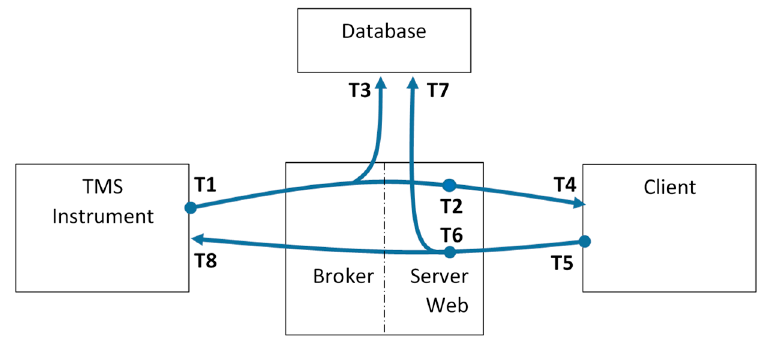
Figure 5. The different timestamps collected for evaluating the proposed time ‐ related metrics.